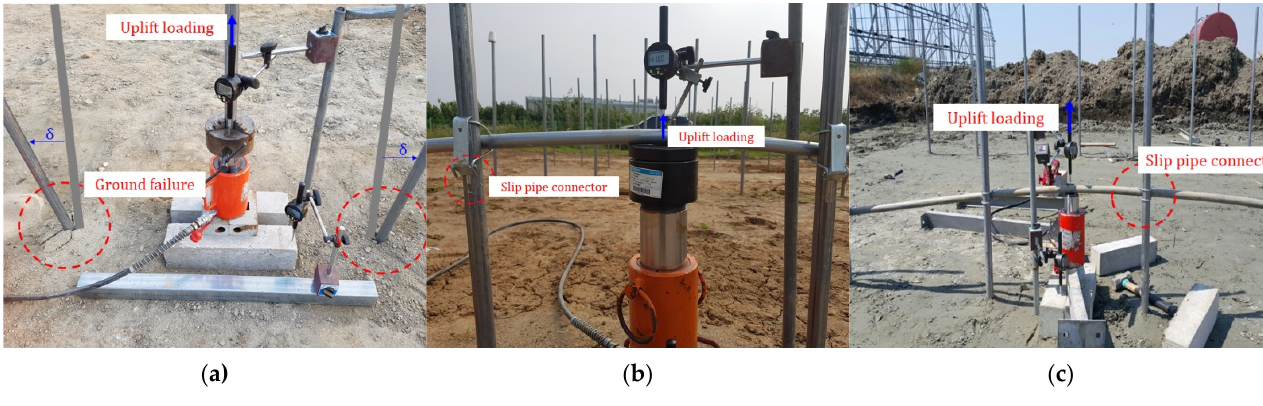
Figure 12. Slipping of pipe connector: ( a ) uplift resistance test method of site A; ( b ) uplift resistance test method of site B; ( c ) uplift resistance test method of site C.